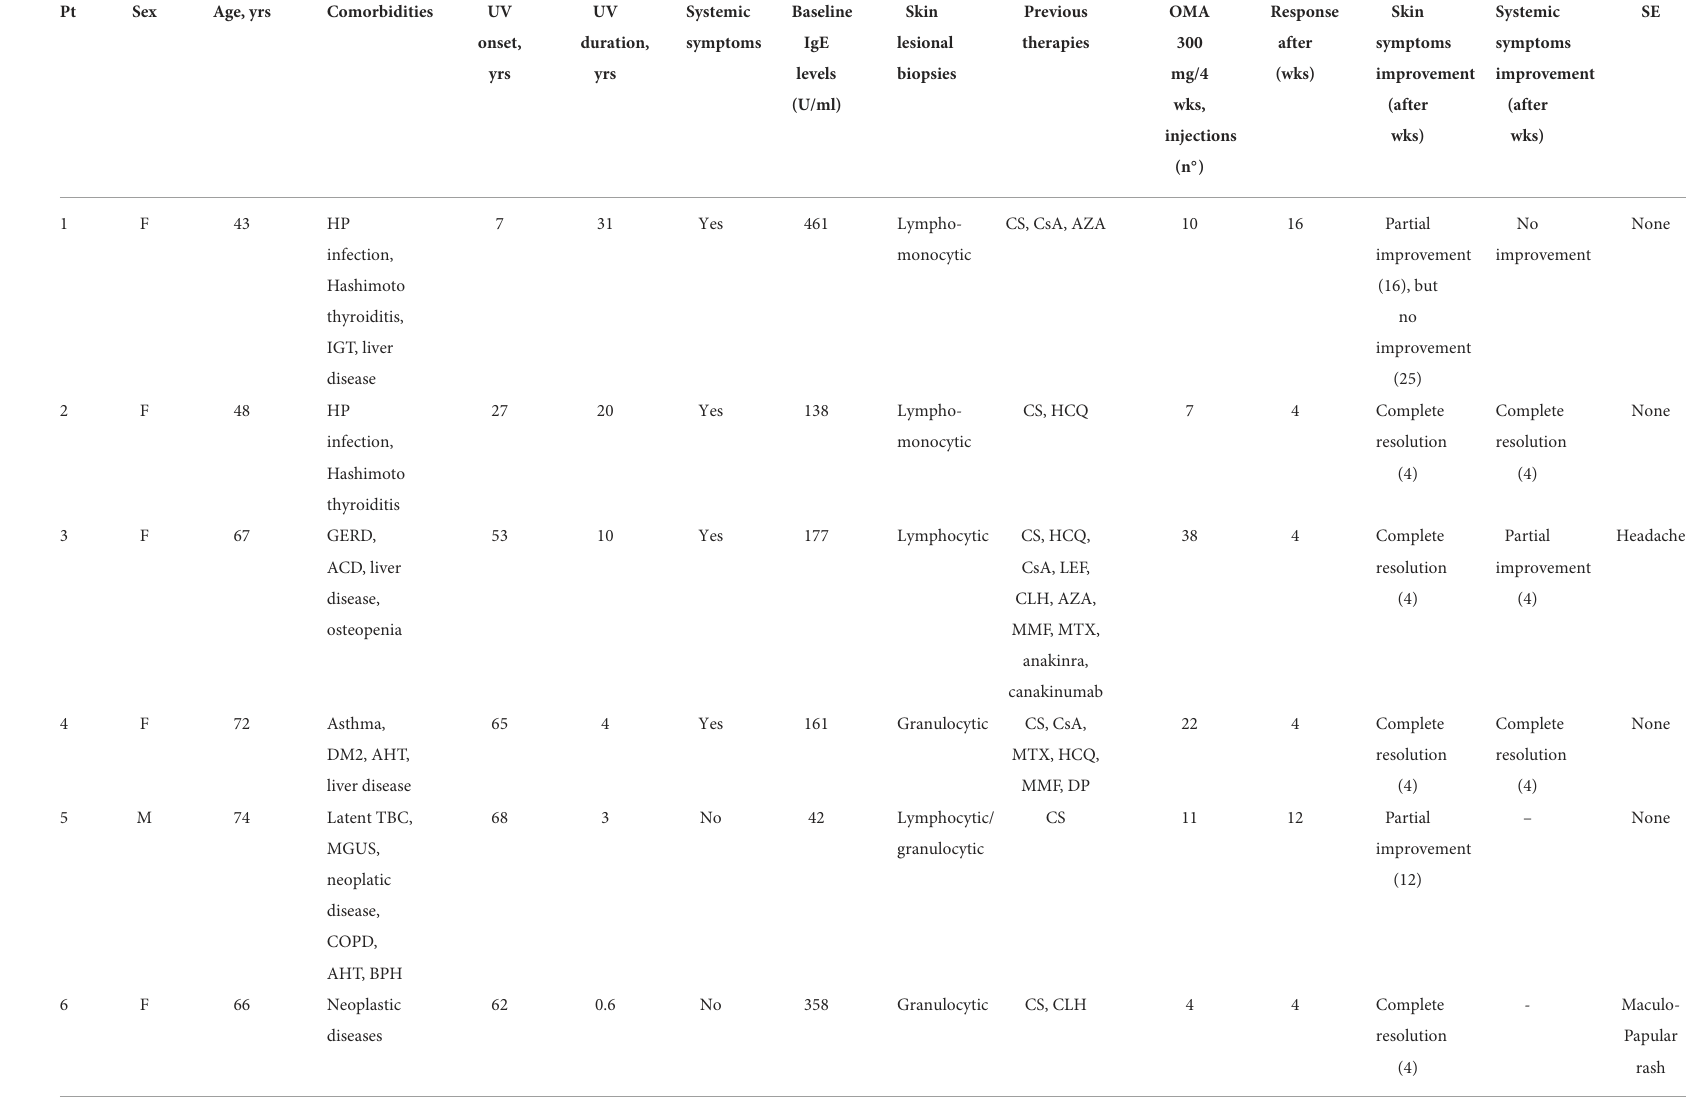
TABLE 1 Demographic and clinical characteristics of patients with normocomplementemic